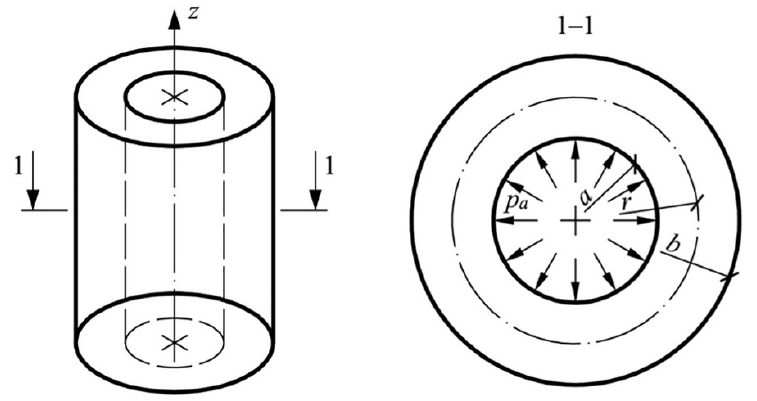
Figure 1. Calculation